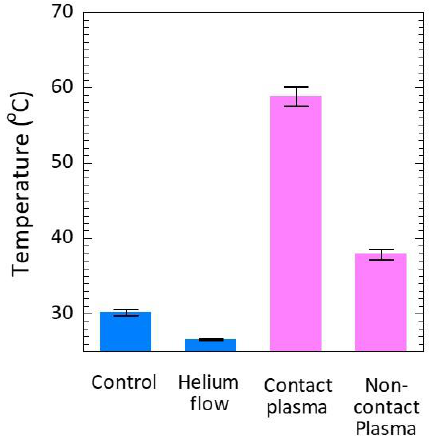
Figure 5. Maximum temperature of mouse skin for untreated mice during He gas flow treatment at 15 min, during contact plasma treatment at 15 min, and during non-contact plasma treatment at 15 min. All data are representative of averages of triplicate measurements.